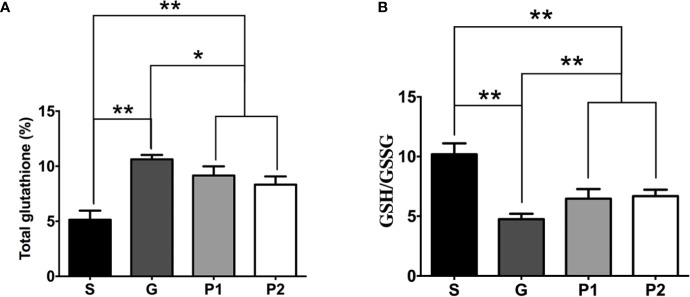
On day 18 after C6 glioma model establishment, CSF was withdrawn from rats, and the total GSH content and GSH/GSSG ratio was determined. (A) Quantification of total GSH content in CSF (n=6/group). (B) The analysis of GSH/GSSG ratio (n=6/group). Data are presented as means ± SD. *P < 0.05 and **P < 0.01. Groups: S, sham; G, glioma; P1 and P2, propofol 20, and 40 mg/kg-1/h-1, respectively. CSF, cerebrospinal fluid; GSH, glutathione; GSSG, glutathione disulfide.